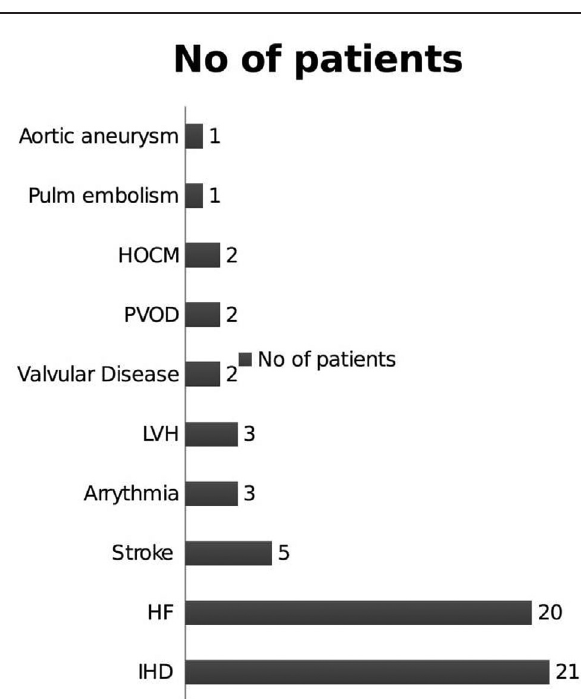
Prevalence of various cardiovascular comorbidities in patients with COPD. COPD, chronic obstructive pulmonary